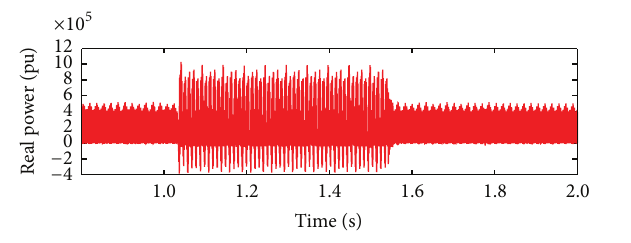
Figure 10: Real power during L-L fault.